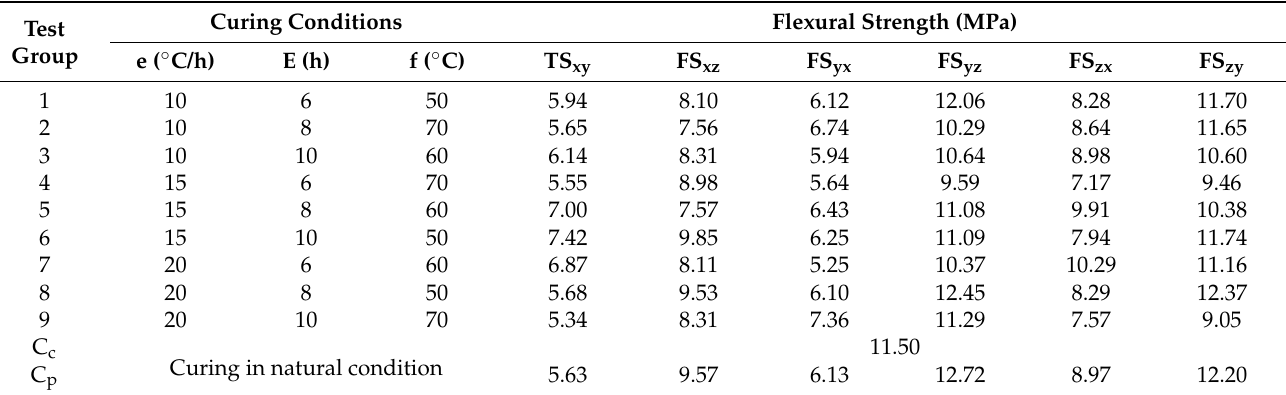
Table 8. Orthogonal experimental table of various test group designs, curing conditions, and flexural strength test data.